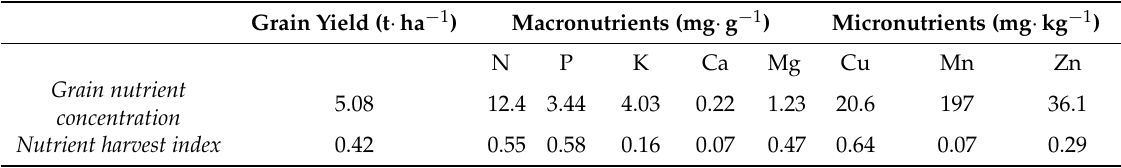
Table 1. Average rice nutrient harvest indices and grain nutrient concentrations in the field trial. Note: data are means from all three N treatments since there was no significant ( p = 0.05) effect of N fertilizer type on grain yield, nutrient harvest indices or grain nutrient